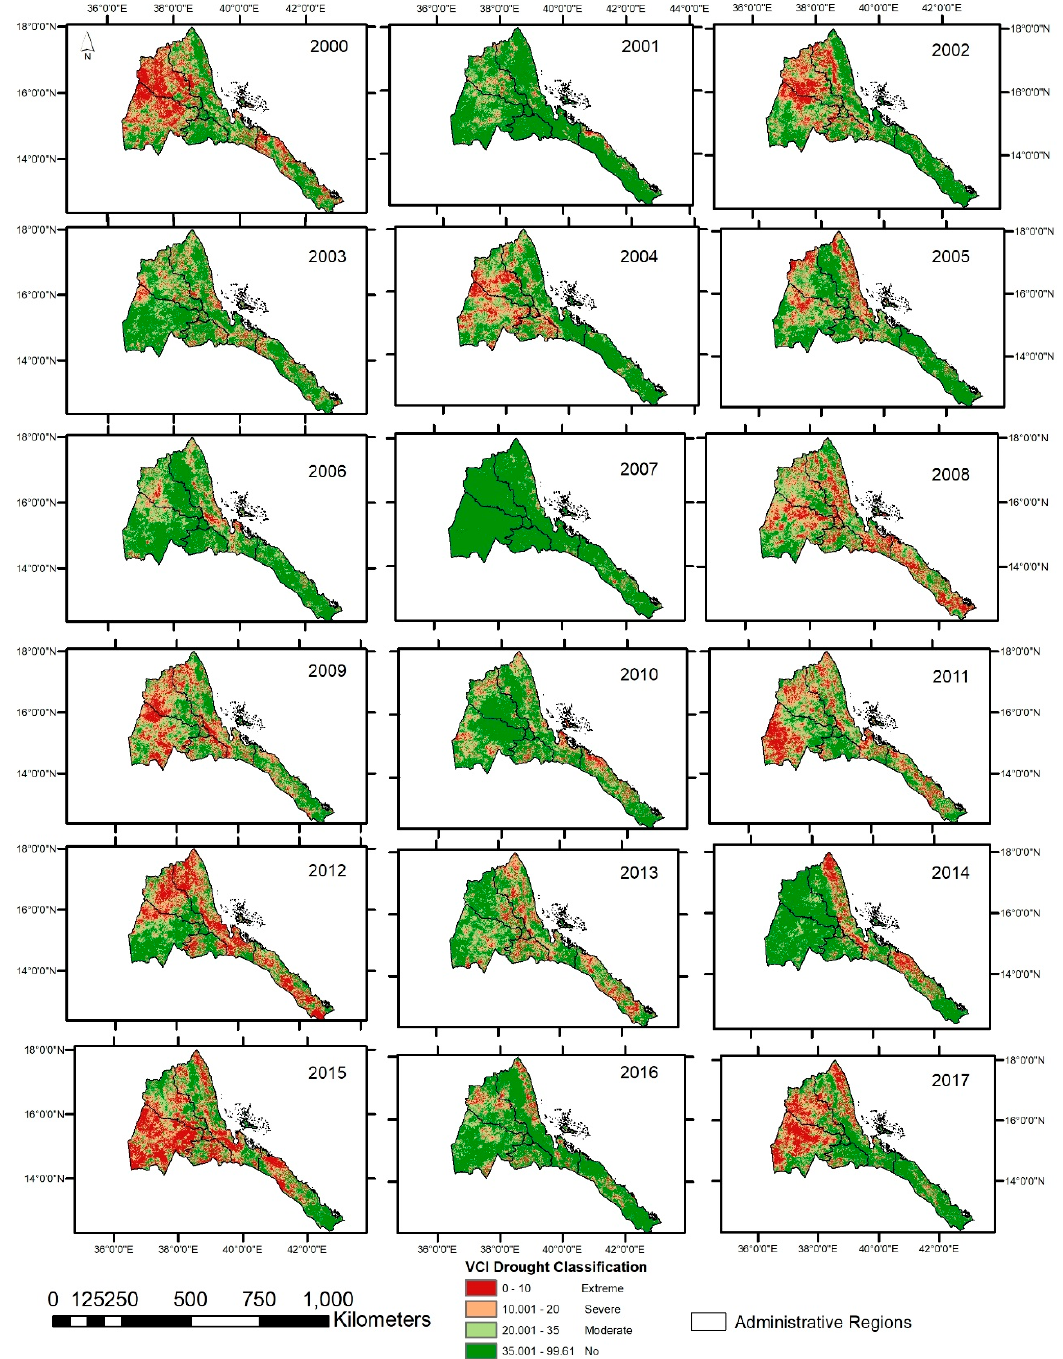
Figure 9. Pixel-based mean VCI distributions in Eritrea during 2000 – 2017.